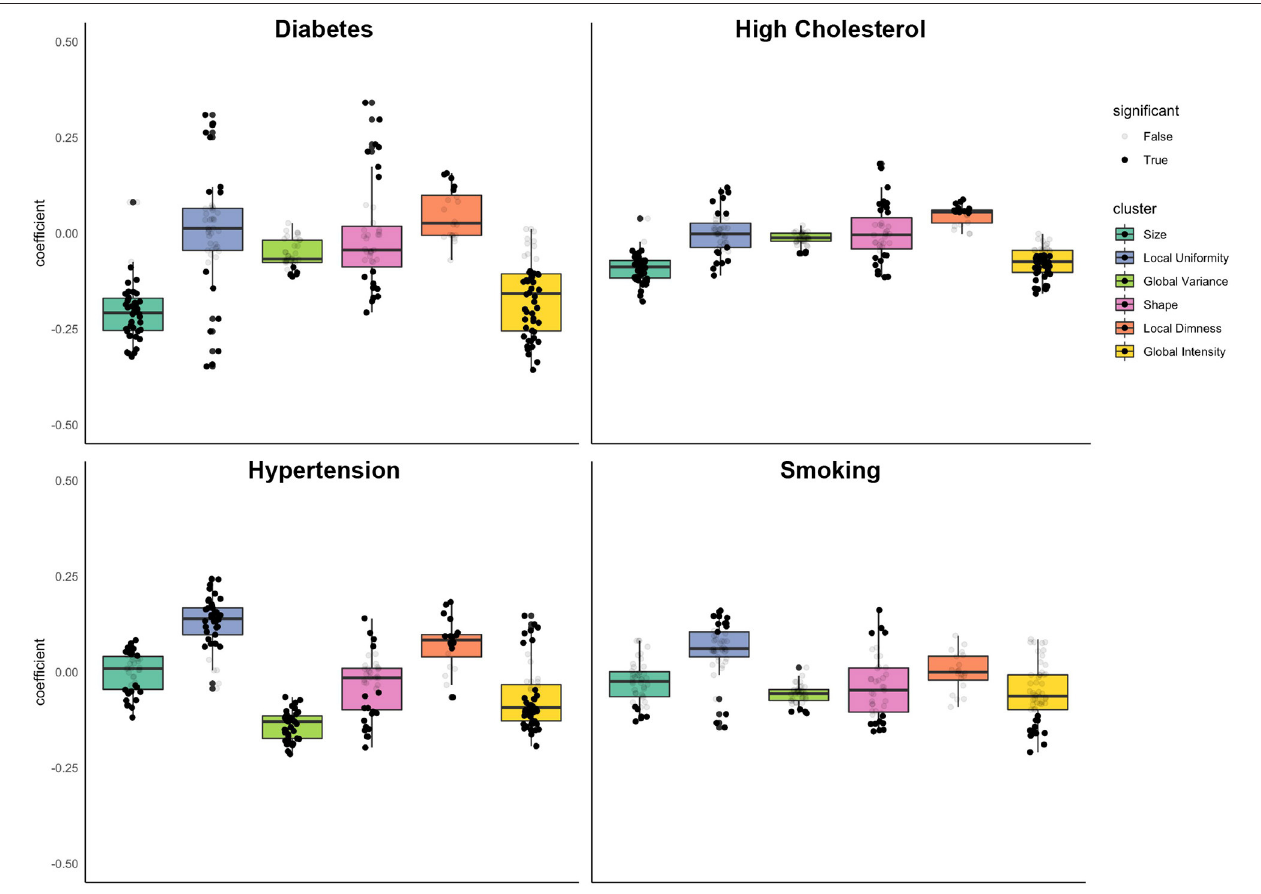
FIGURE 4 | Associations of diabetes, high cholesterol, hypertension, and smoking with radiomics features grouped into clusters. Results are from linear regression models adjusted for age, sex, and body surface area, diabetes, high cholesterol, hypertension, and smoking. The y axis is standardised beta coefficients for associations of vascular risk factors (diabetes, high cholesterol, hypertension, smoking) with radiomics features. Each dot represents point estimate of association with a radiomic feature from a separate model. Black dots indicate statistically significant associations. Grey dots indicate non-significant associations. Statistical significance is based on Bonferroni adjusted p -value < 0.05. Feature associations are grouped into previously defined clusters ( Figure 1 ; Table 1 ). The dark line in the box plot indicates the median beta coefficient in the cluster, the box borders indicate limits of the interquartile